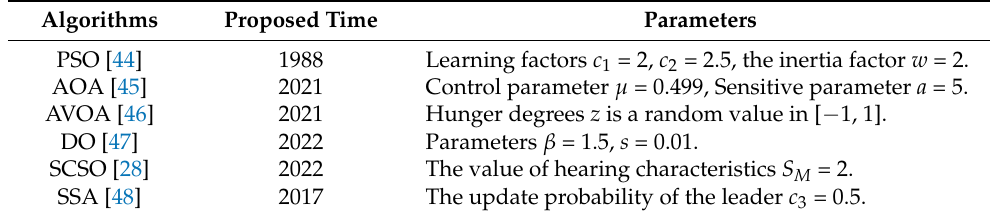
Table 1. Parameters of the algorithms.